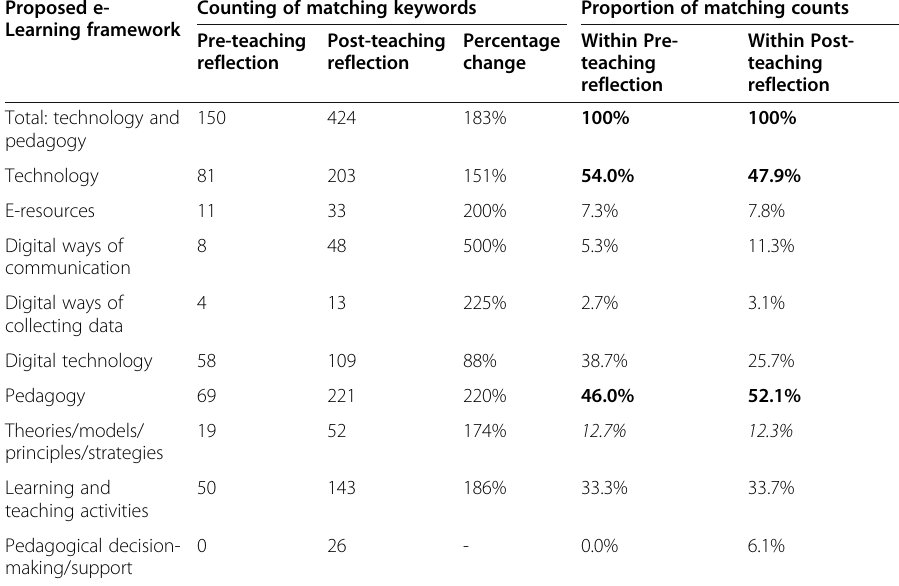
Table 6 The percentage change of counting of matching keywords and proportions of matching counts at all levels of the e-Learning framework in the pre-teaching and post-teaching reflections Proposed e- Counting of matching keywords Learning framework